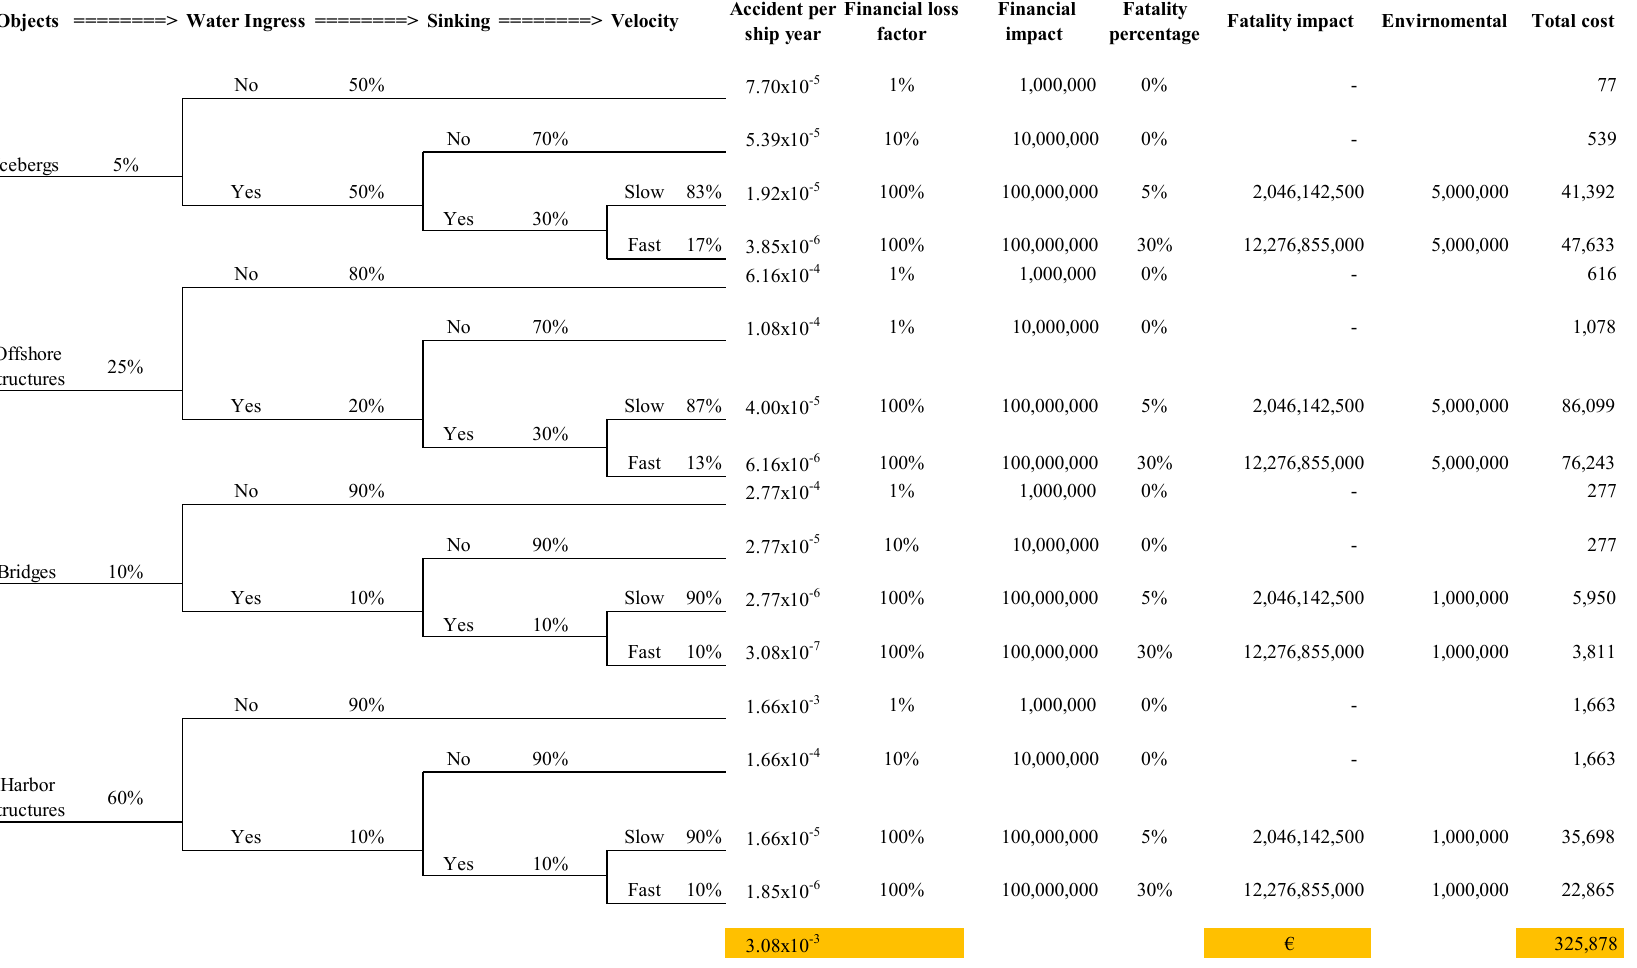
Figure 14. Event tree analysis of contact for passenger ships.